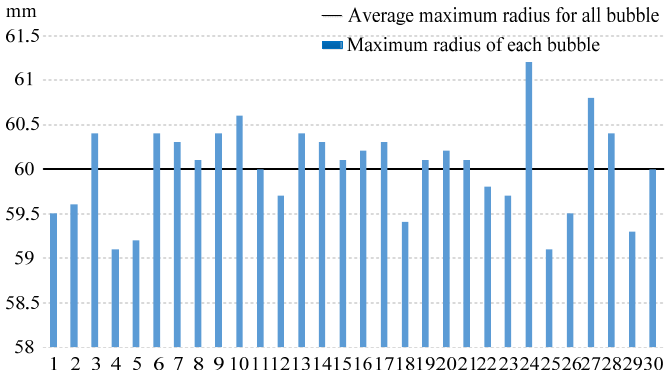
Figure 7. The maximum radius of the bubble generated in the free field through a 400 V discharge. The solid line is the average value of the maximum radius of the bubble.